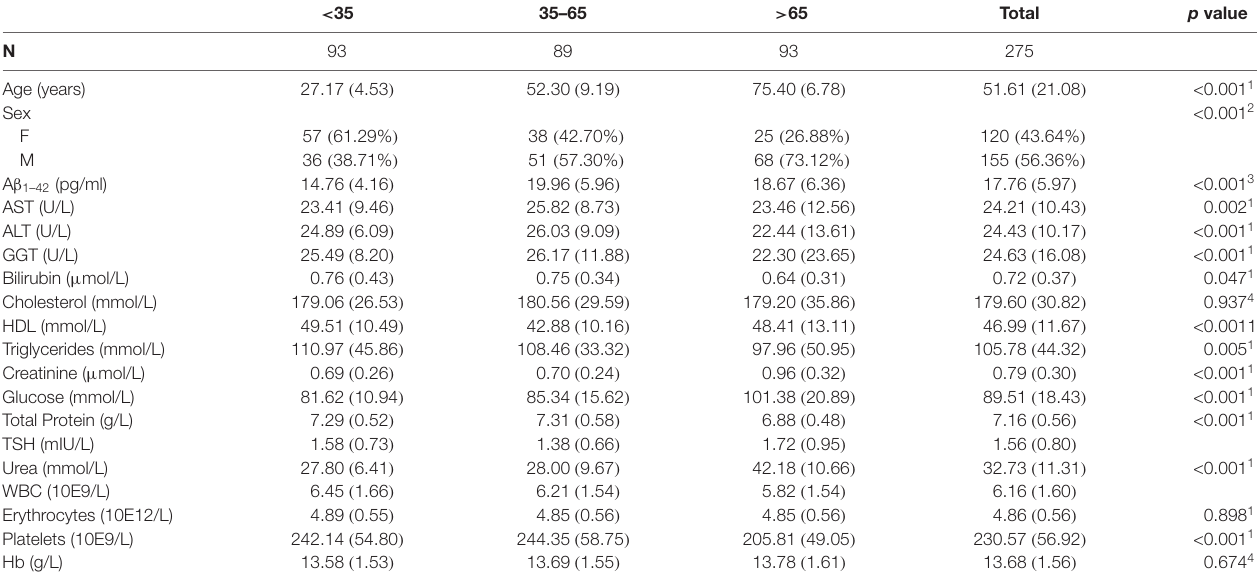
TABLE 1 | Demographic characteristics and baseline biochemical and hematological